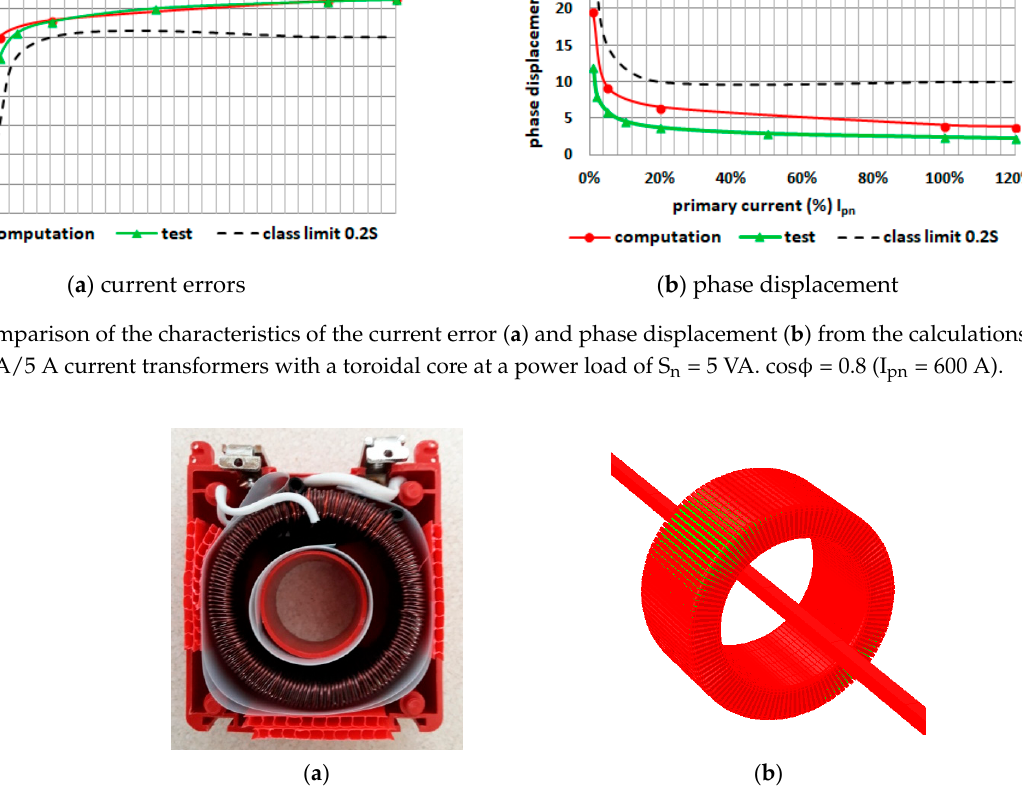
( b ) phase displacement Figure 9. Comparison of the characteristics of the current error ( a ) and phase displacement ( b ) for 600 A/5 A of current transformers with different cores and secondary windings arrangements at a power load of S n = 2.5 VA. cos ϕ = 0.8 (I pn = 600 A) S n = 2.5 VA. cos φ = 0.8 (I pn = 600 A).